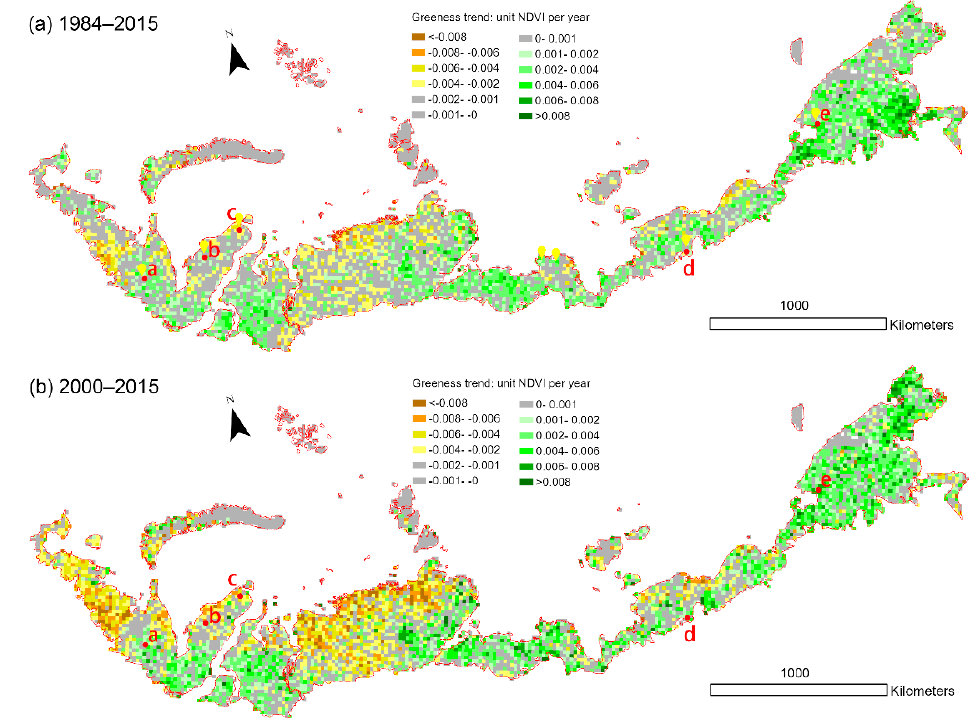
Figure 8. The greenness trend maps derived from AVHRR: ( a ) the greenness trend values from 1984 to 2015; ( b ) the greenness trend values from 2000 to 2015. The detailed trend results labeled a–e are displayed in Figure 9.